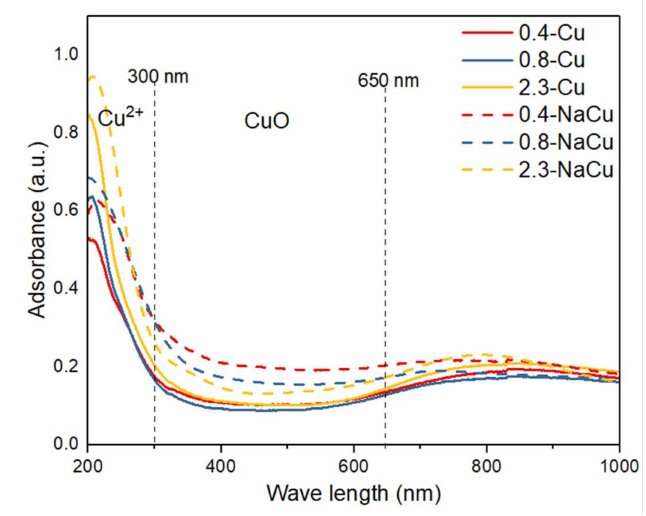
Figure 6. UV–vis spectra of the Cu/SSZ-13 with different crystal